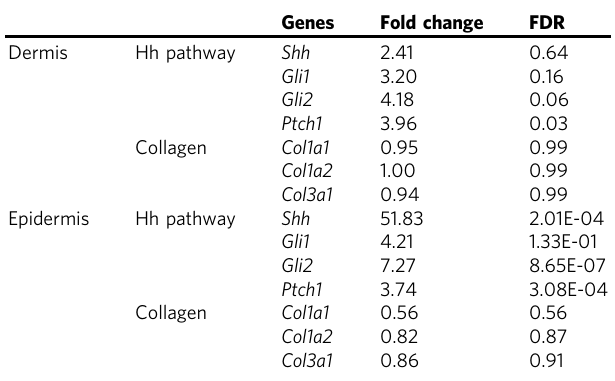
Table 1 Comparison of Hh pathway component and collagen expression between K14-Shh and control mice based on RNA-seq Genes Fold change FDR Dermis Hh pathway Shh